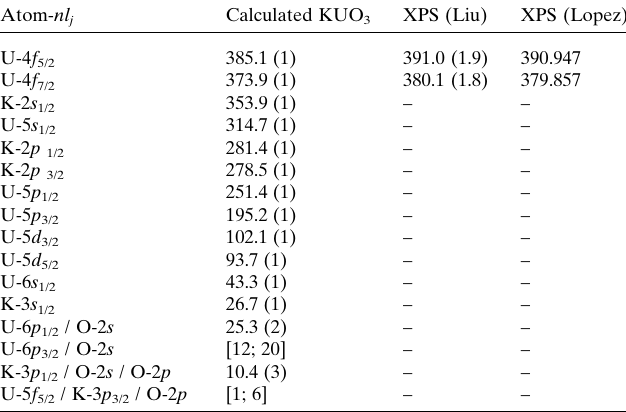
Table 4 Electron binding energies (in eV) in KUO 3 as deduced from the calculated density of states down to U-4 f electrons. Energies given in brackets refer to the energy range where density of states show multiplet structure, which is especially the case in the valence molecular orbitals. Experimental data are from X-ray photoelectron spectroscopy experi- ments from Liu et al. (2009) and from Lopez et al. (2017). Experimental uncertainties in Liu’s data refer to the line width at half